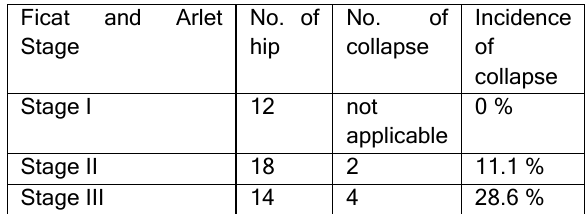
Table 2. Correlation between Ficat and Arlet stage, and